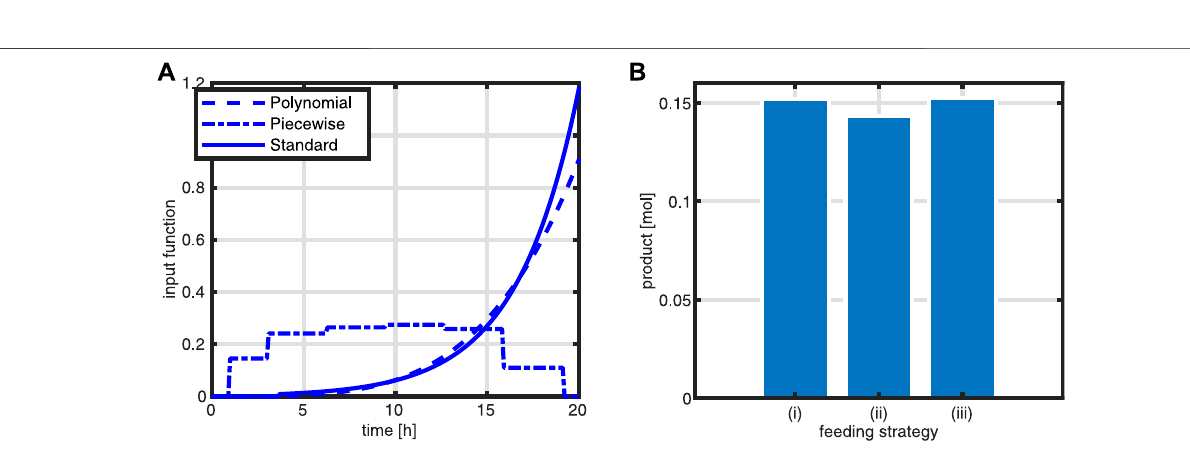
FIGURE11| Comparison oftheoutcome ofthethreestrategies. Time courseforthefeeding q in asafunctionoftime (A) ;valueoftheobjectivefunction(fromleftto right: standard feeding, polynomial function, and piece-wise function) (B) .